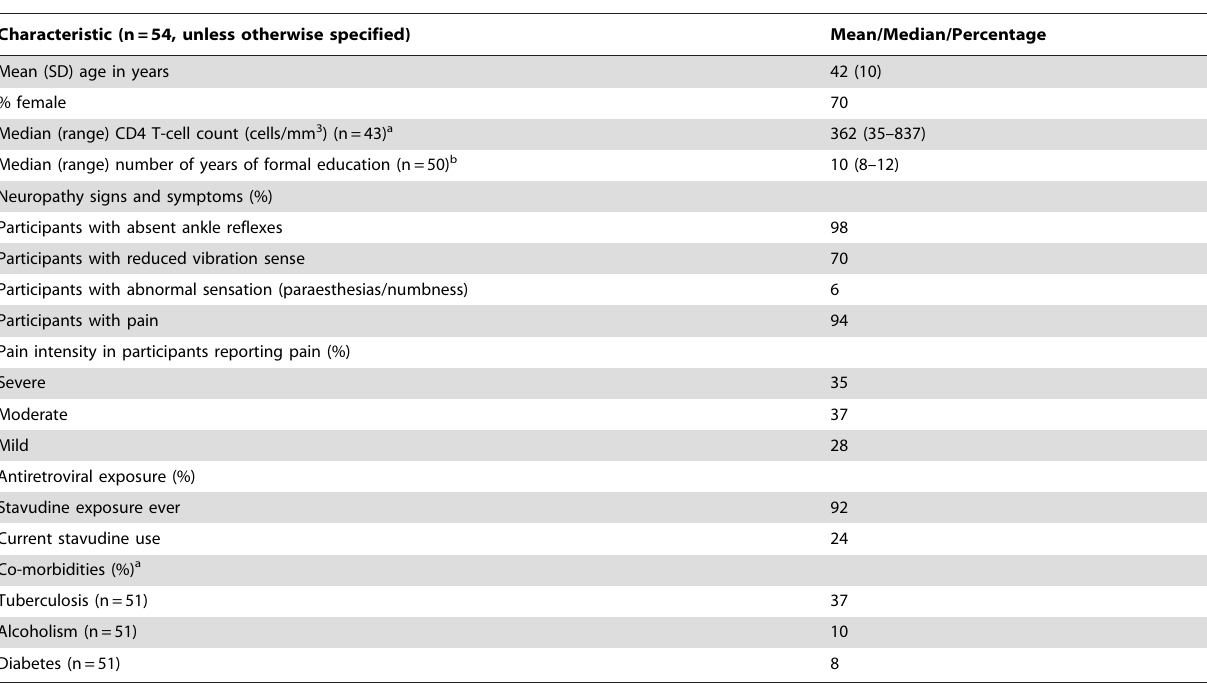
Table 2. Demographic and disease-related characteristics of